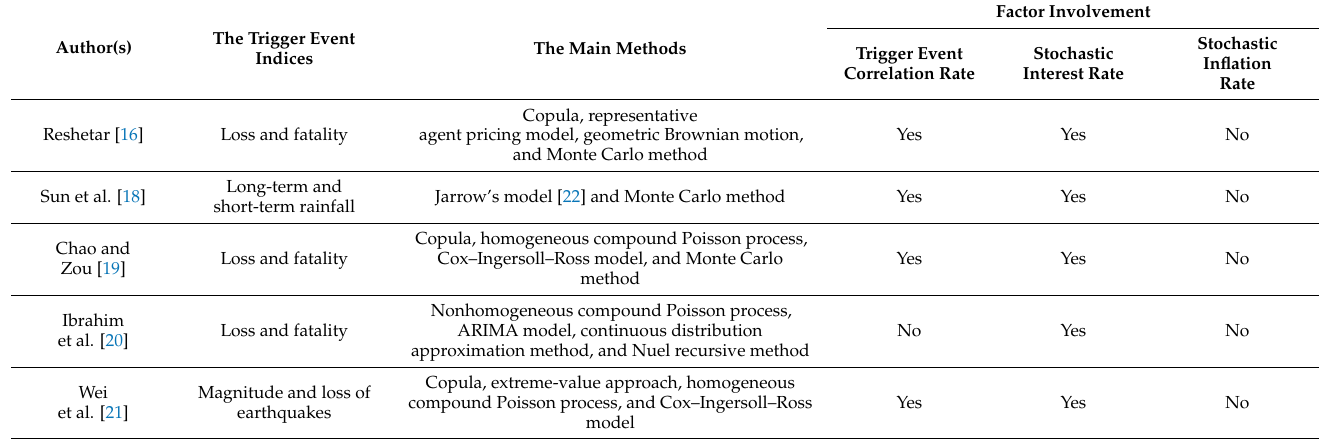
Table 1. The previous studies on the design of the MECB pricing